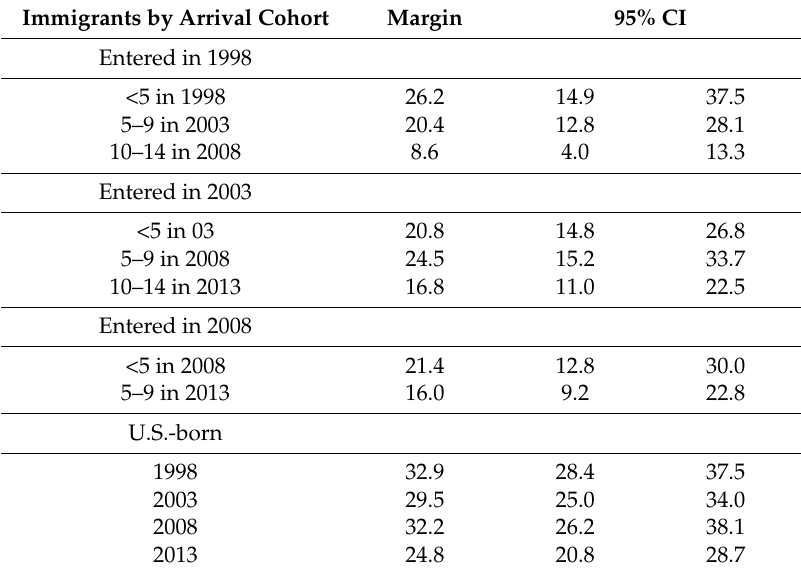
Table 3. Predicted prevalence of smoking among Latino men by immigrant cohort: Tracking method. Immigrants by Arrival Cohort Margin 95%